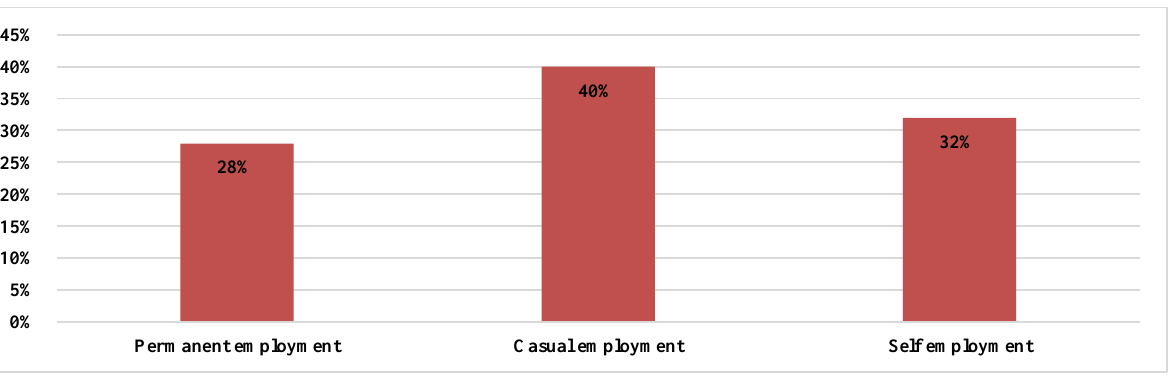
Figure 1: Type of Occupation; Source: Field Data